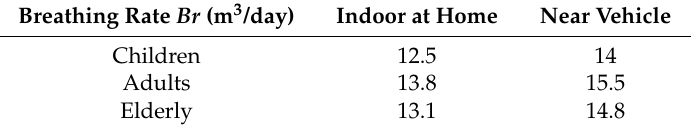
Table 3. Breathing rate for various age groups in different microenvironments